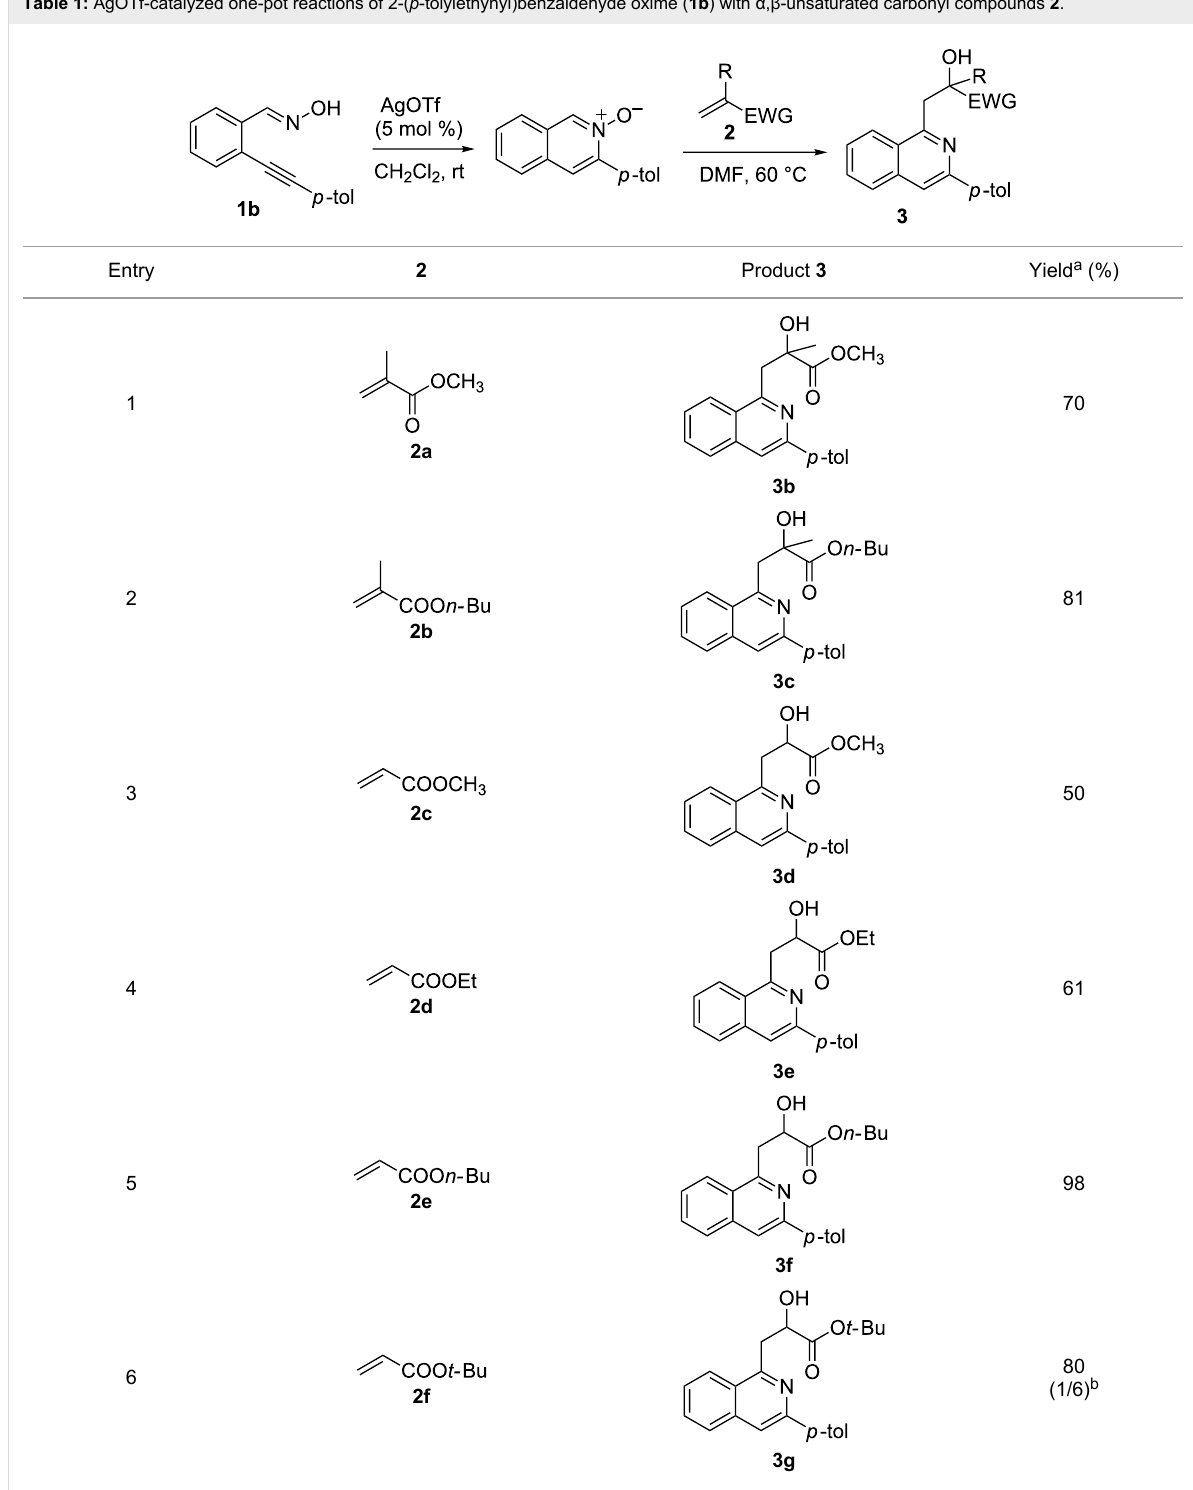
Table 1: AgOTf-catalyzed one-pot reactions of 2-( p -tolylethynyl)benzaldehyde oxime ( 1b ) with α , β -unsaturated carbonyl compounds 2